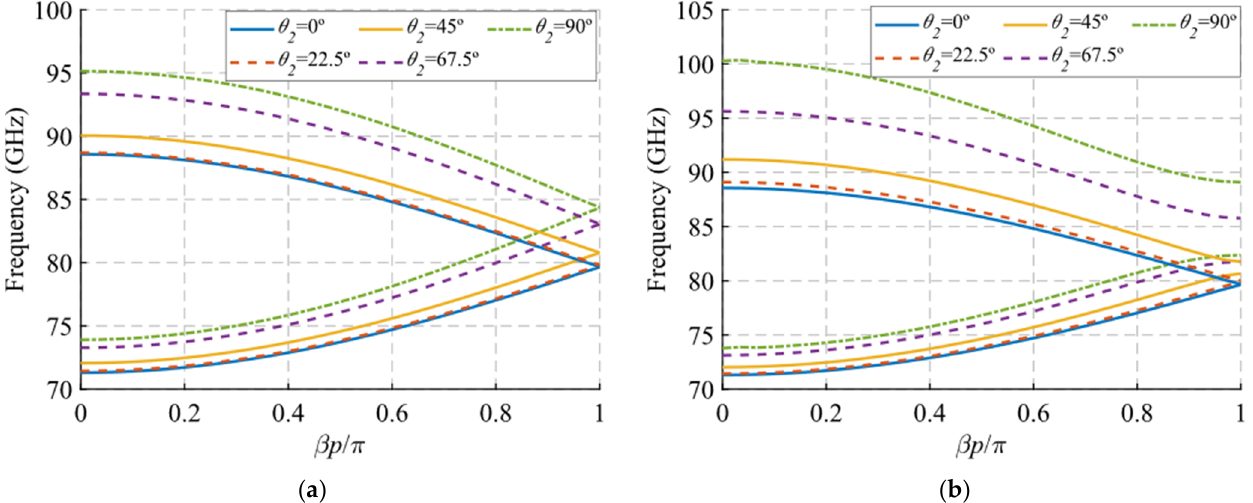
Figure 14. Dispersion diagram of the single-periodic unit cell for various values of θ 2 . ( a ) Glide- symmetric configuration ( d = 0.725 mm) and ( b ) maximum rupture of symmetry configuration ( d = 0 mm).